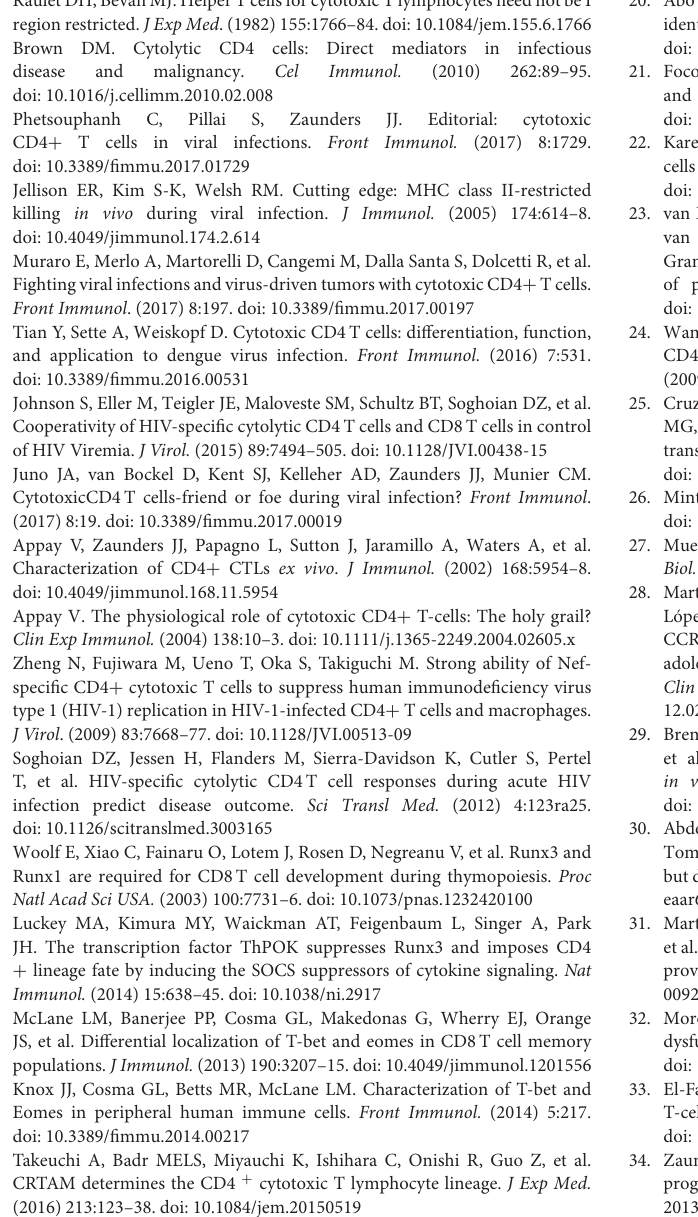
Supplementary Figure 7 | CD57 + dysfunction in HIV infection. (A) Dysregulation of CD57 + proliferation in ART treated primary HIV donors. (B) Caspase-3